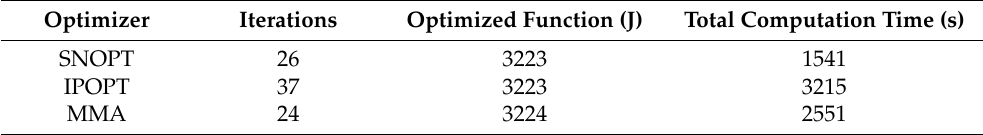
Table 4. Computational times for the three